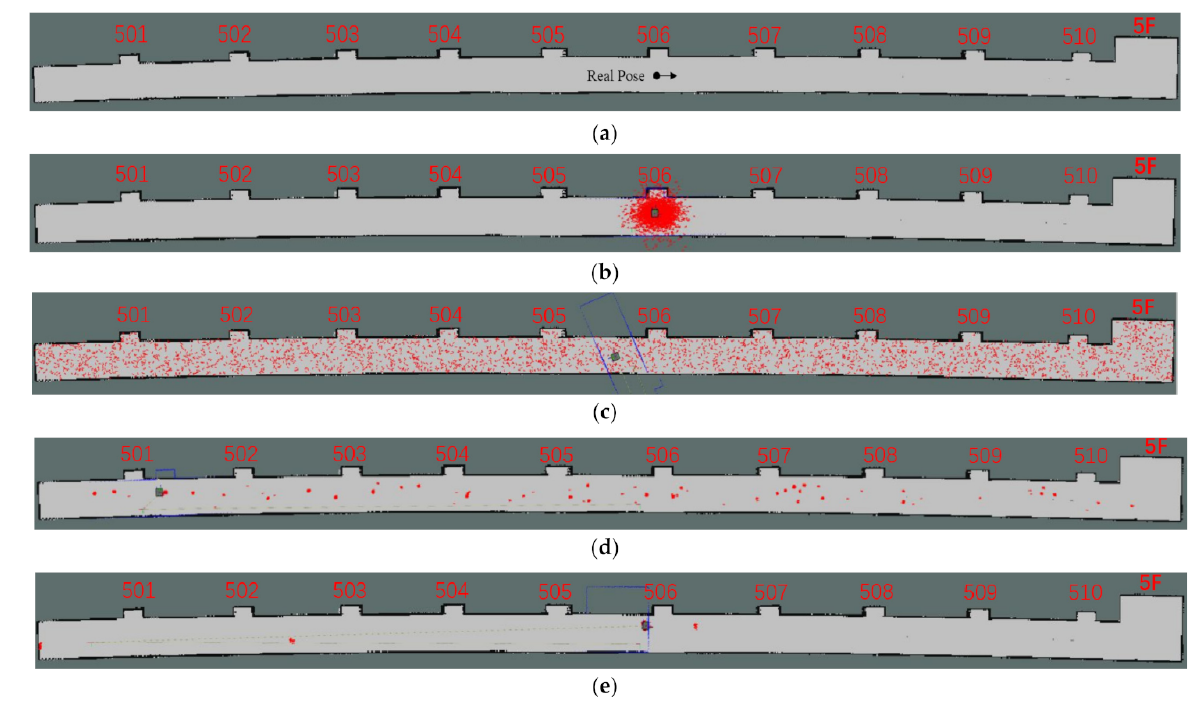
Figure 10. Global localization results using AMCL method. ( a ) Real pose in the map. ( b ) Initial particle distribution with a pose given manually. ( c ) Initial particle distribution without a known pose. ( d ) Particle distribution after moving a short distance. ( e ) Particle distribution when the robot reached position #12.